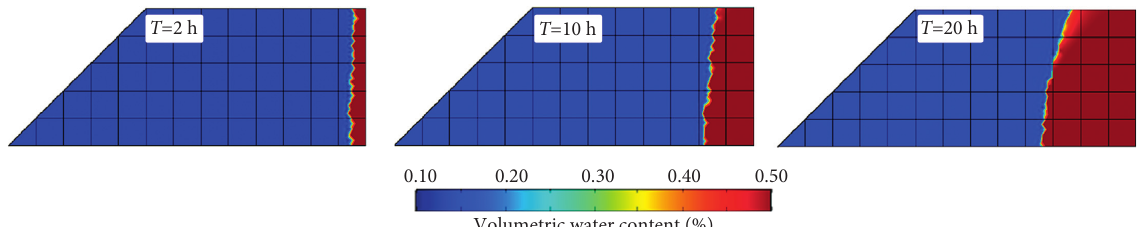
Figure 13: Variation of the water content with time obtained by the single-domain flow model.